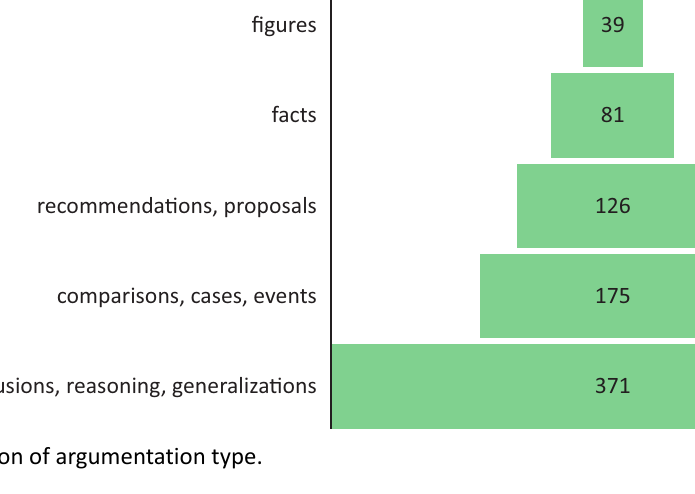
Figure 1. Distribution of argumentation type.